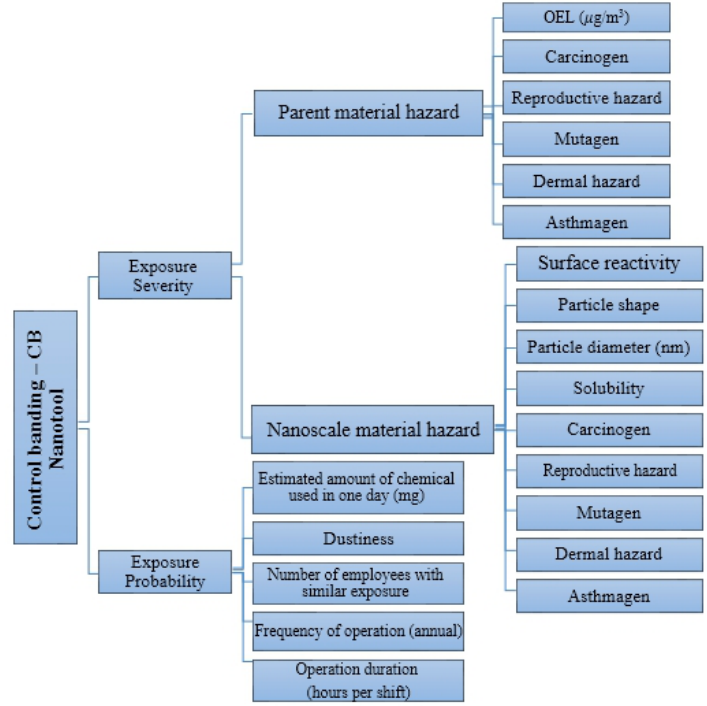
Fig. 7. Flowchart of the Control Banding risk assessment methodology and the hazard severity and exposure probability